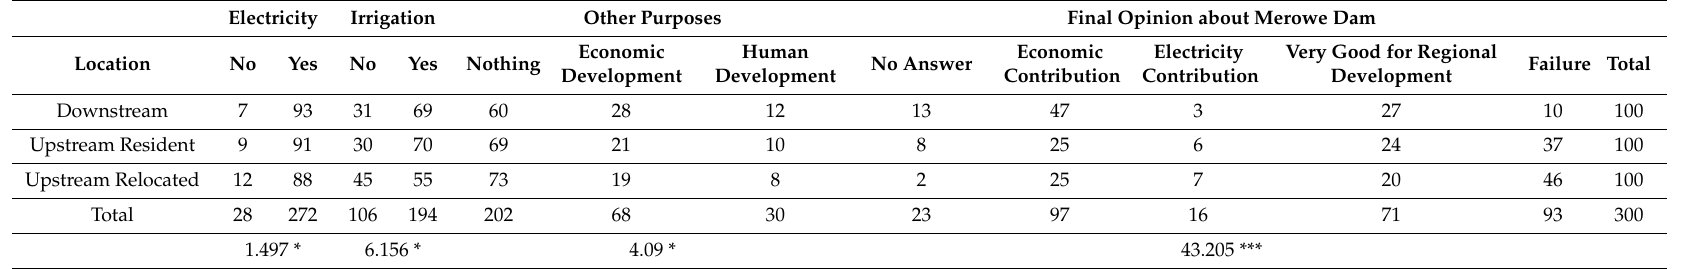
Table 2. Participants’ perception on Merowe Dam’s agricultural and non-agricultural economic benefits by location. Electricity